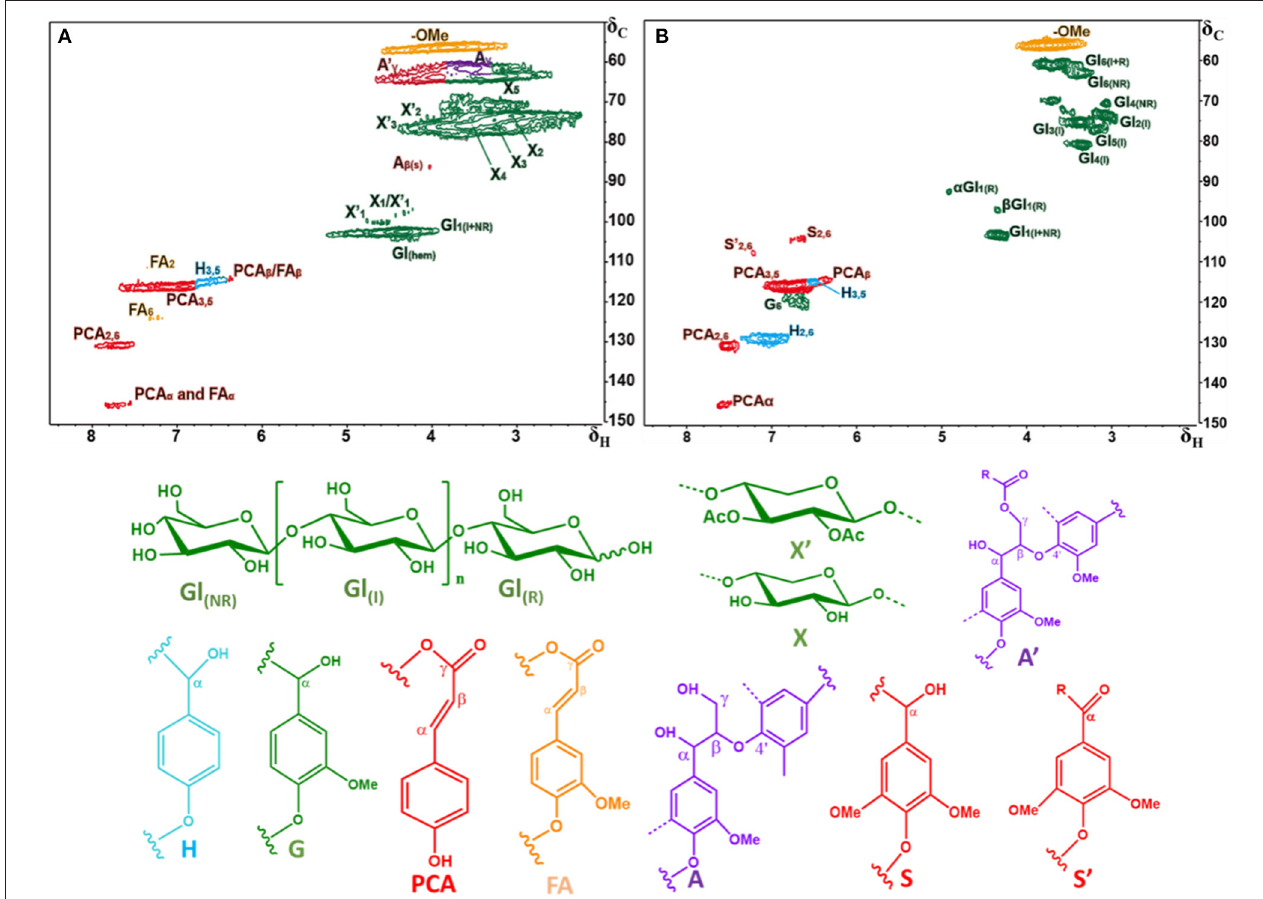
FIGURE 2 | 2D-HSQC NMR spectra and the main structures of the corncob (A) and furfural residue (B)